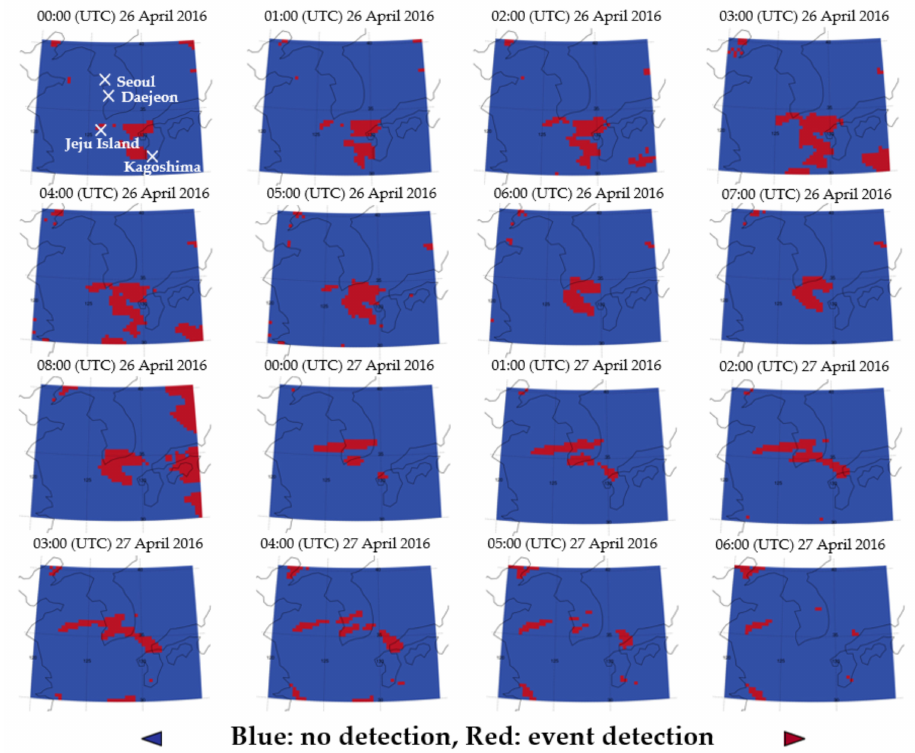
Figure 13. Spatial distribution of the pixels affected by volcanic LRT-SO 2 for event 3 over the period 26–27 April 2016.